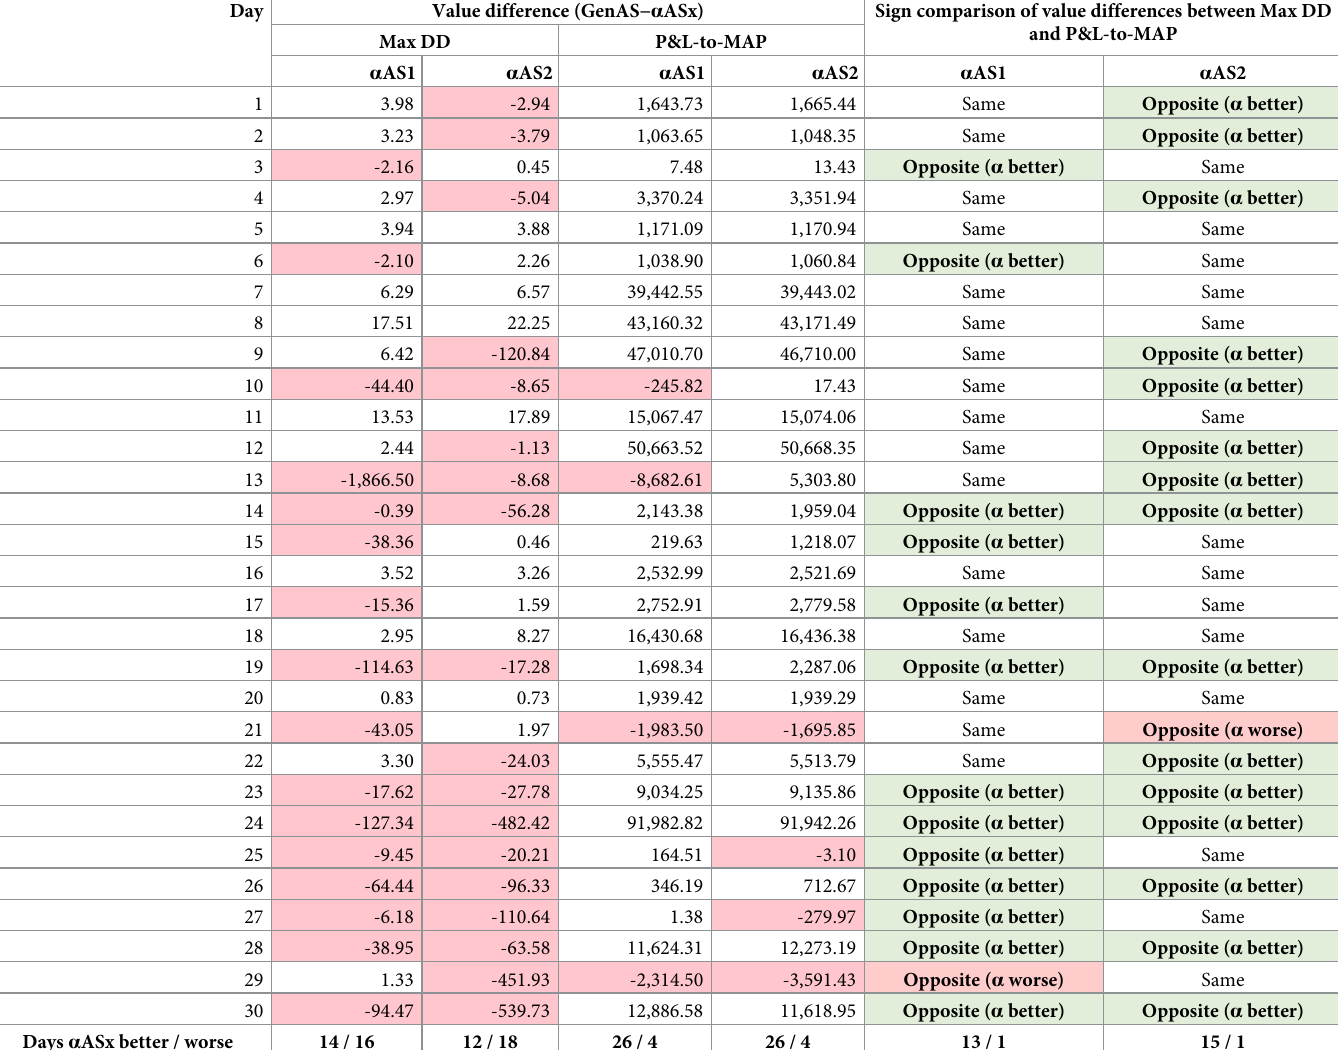
Table 8. Comparison of values for Max DD and P&L-to-MAP between the Gen-AS model and the Alpha-AS models ( α AS1 and α AS2). The “Sign comparison of value differences” side of the table (right) highlights in green (Alpha-AS “better”) the test days for which the respective Alpha-AS models performed worse on Max DD but better on P&L-to-MAP relative to the Gen-AS model, the latter being the more desirable indicator in which to perform well (since maximizing the P&L profile is the central point of the AS method). Conversely, test days for which the Alpha-ASs did worse than Gen-AS on P&L-to-MAP in spite of performing better on Max DD are highlighted in red (Alpha-AS